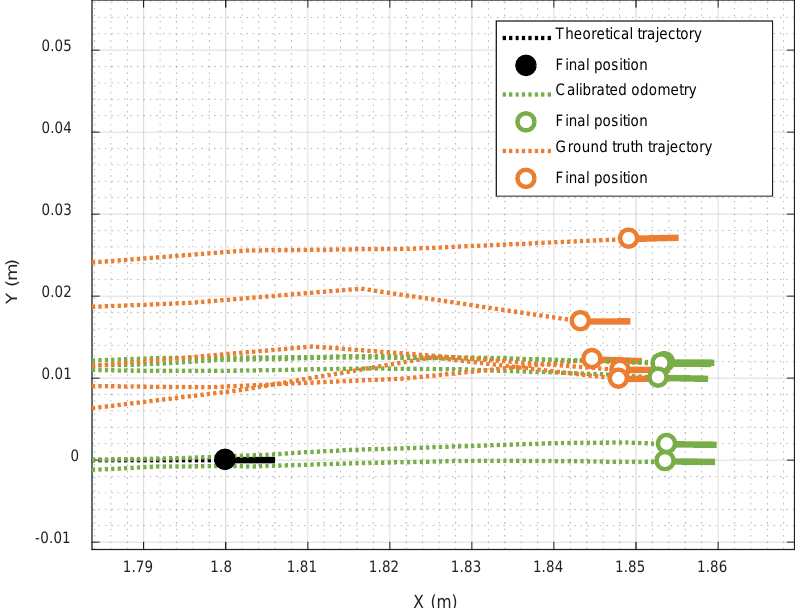
Figure 10. Planned trajectory (back dotted line) zoomed at the planned ending position and orientation of the mobile robot (black point and line); measured ground truth trajectories (orange dotted line) detailing the final position and orientation of the mobile robot (orange circle and line); and odometry trajectories measured after calibration (green dotted line) detailing the ending position and orientation of the mobile robot (green circle and line).